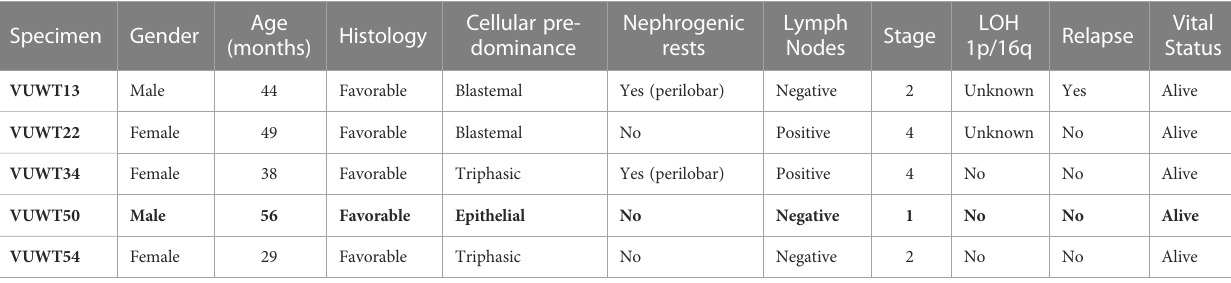
TABLE 2 Clinical data for Wilms tumor specimens enzymatically dispersed and cultured.*